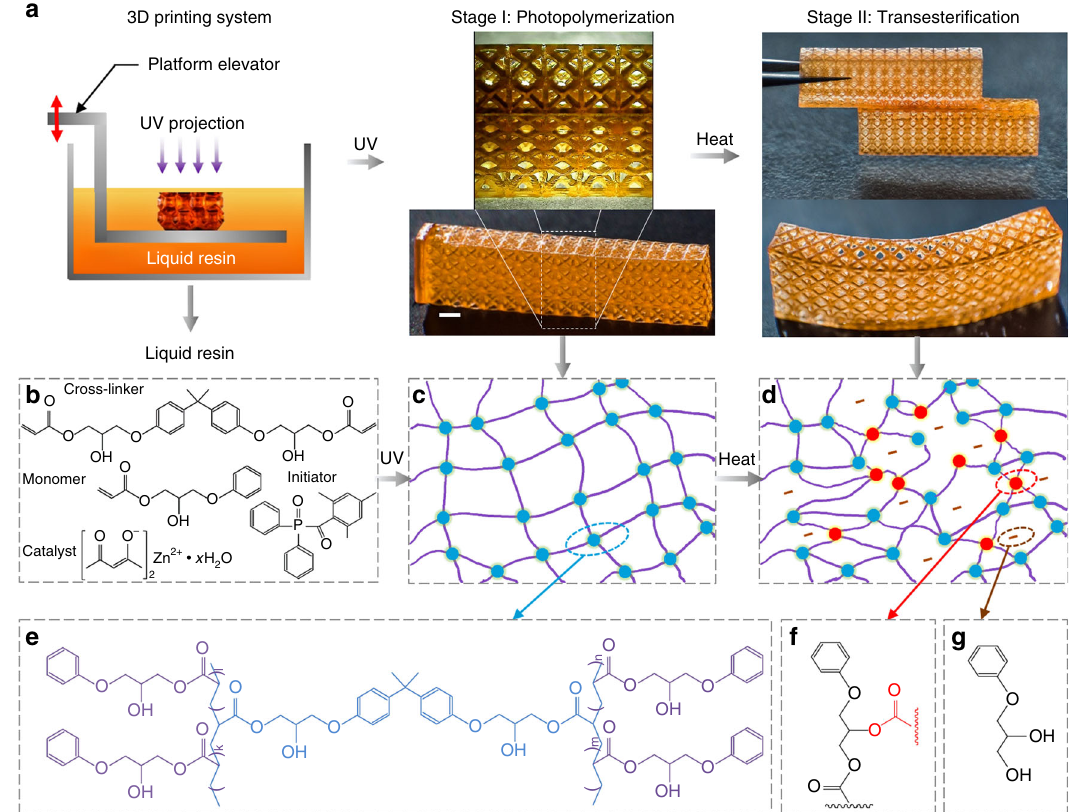
Fig. 1 3D printing reprocessable thermosets. a General route of 3D printing high-resolution lattice structures with a UV curing-based 3D printing system using the reprocessable thermosetting polymer solution (Stage I). Heating then imparts the reprocessability into the printed structures. Two separate printed lattice structures can be welded together, and a straight lattice structure can be programmed into a bent one (Stage II). Polymer chemistry involved in the two-step polymerization; b chemical structures of monomer, crosslinker, initiator, and catalyst in the photopolymer solution; c UV curing forms the permanent covalent bonds (blue dots); d thermal-triggered transesteri fi cation leads to the formation of DCBs (red dots). Chemical structures of the resultant permanent crosslinked network of Stage I ( e ) and DCBs of Stage II after heating ( f , g ). Scale bar: 1